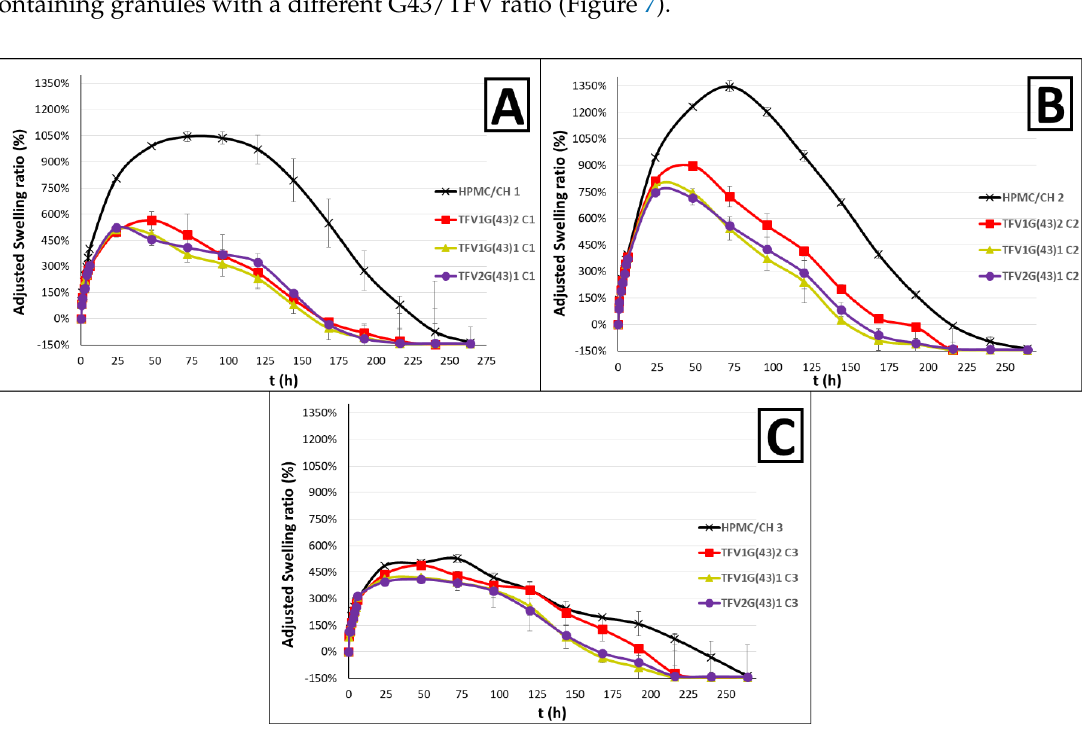
Figure 7. Adjusted swelling ratio profiles obtained from batches containing TFV/G43 drug-loaded granules in HPMC/CH matrices with equal ratios of both polymers ( A ); more HPMC than CH ( B ); and more CH than HPMC ( C ). They are all compared with standard formulations of HPMC/CH